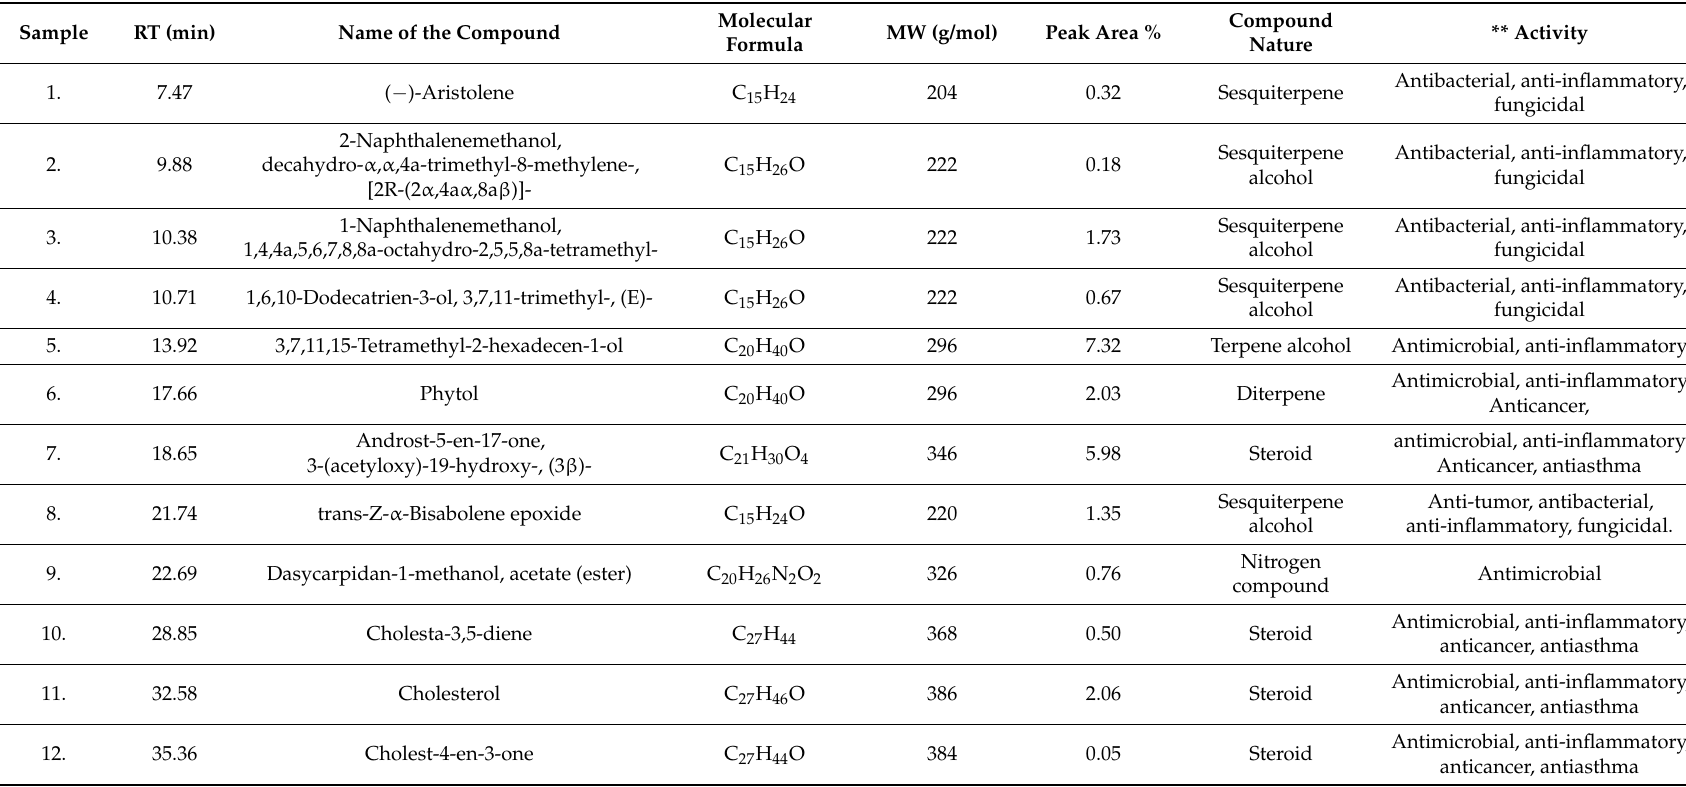
Table 3. Bioactive compounds identified in ethanolic fractions of L. paniculata by GC–MS/MS